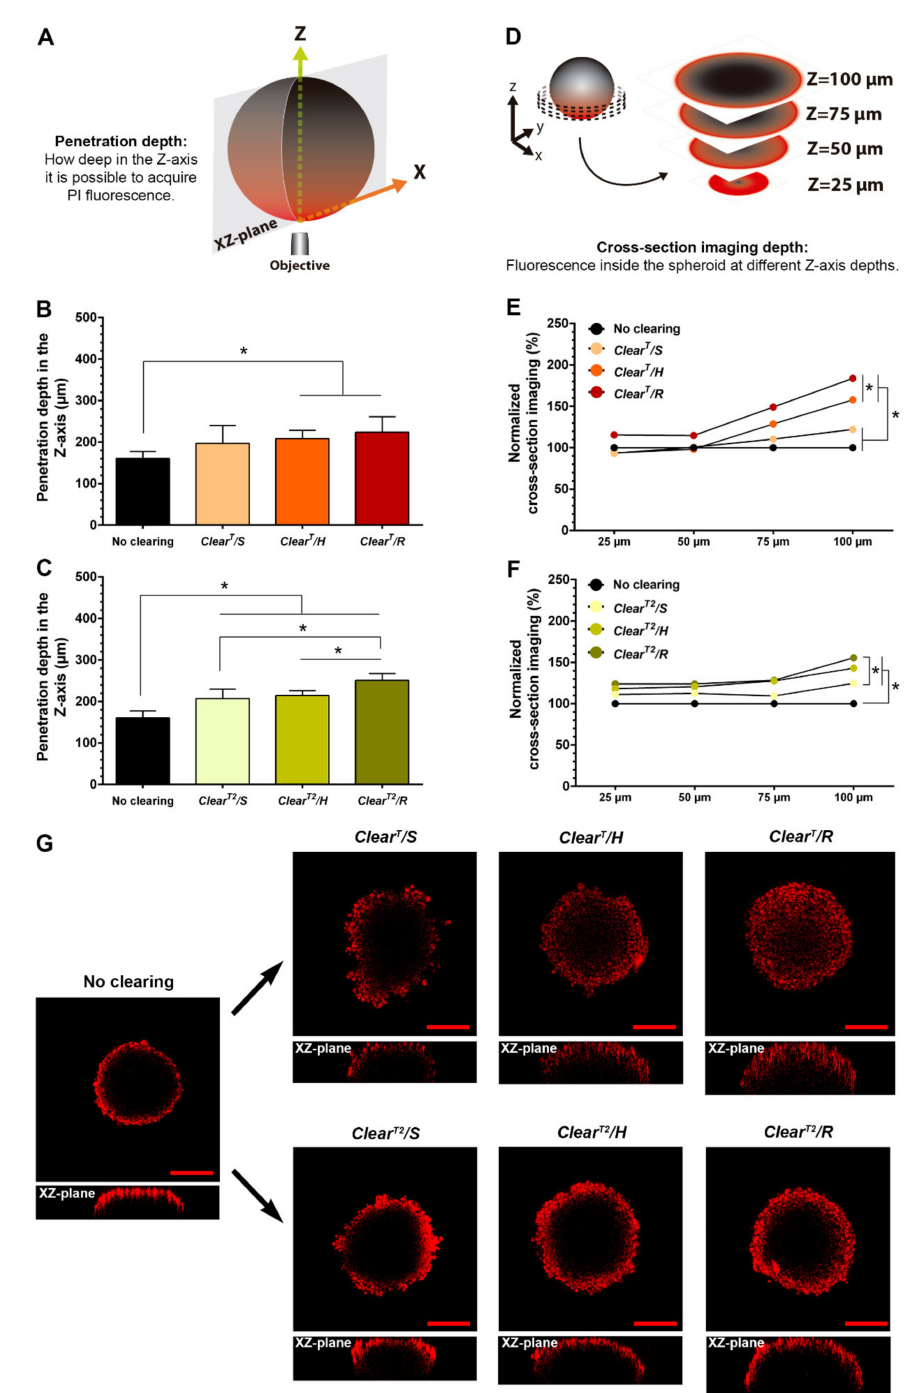
Figure 4. Influence of the immersion conditions used to perform the Clear T and Clear T2 methods on the PI imaging depth in the Z-axis and the PI cross-section imaging depth in HFIB spheroids. Schematic representation of the penetration depth in the Z-axis measured in the spheroids ( A ). The penetration depth of PI fluorescence signal in the Z-axis of non-cleared spheroids and spheroids cleared by using Clear T ( B ) and Clear T2 ( C ) methods under static, horizontal agitation, and rotatory agitation conditions. Schematic representation of the PI cross-section imaging depth measured in the spheroids ( D ). Cross-section imaging depth of PI fluorescence signal of spheroids cleared by using Clear T ( E ) and Clear T2 ( F ) methods under static, horizontal agitation, and rotatory agitation conditions, normalized to the average of the non-cleared spheroids values. Cross-section CLSM images of non-cleared and cleared spheroids by using Clear T and Clear T2 methods under static, horizontal and rotatory agitation conditions ( G ). Scale bars correspond to 200 µ m; n = 9, * p < 0.05,